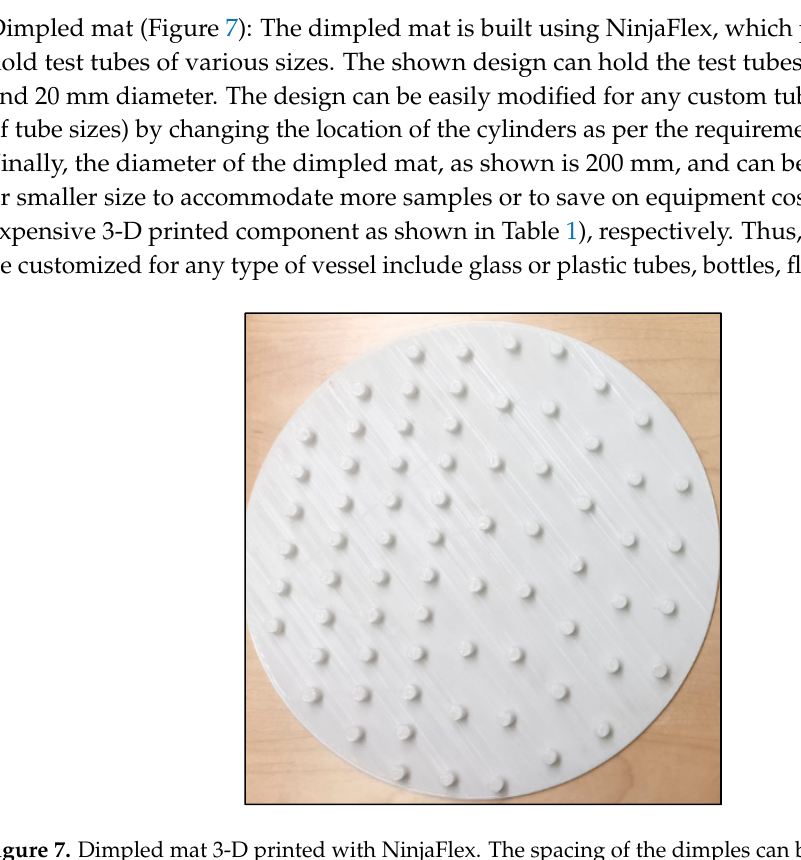
Figure 8. NinjaFlex slit design.